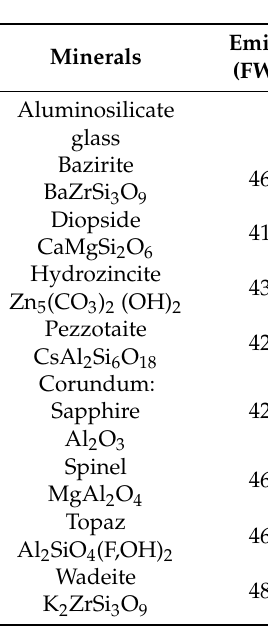
Table 3. Summary of luminescent properties of natural compounds containing extrinsic Ti for which BSL has been documented. For all, the perceived luminescence color is